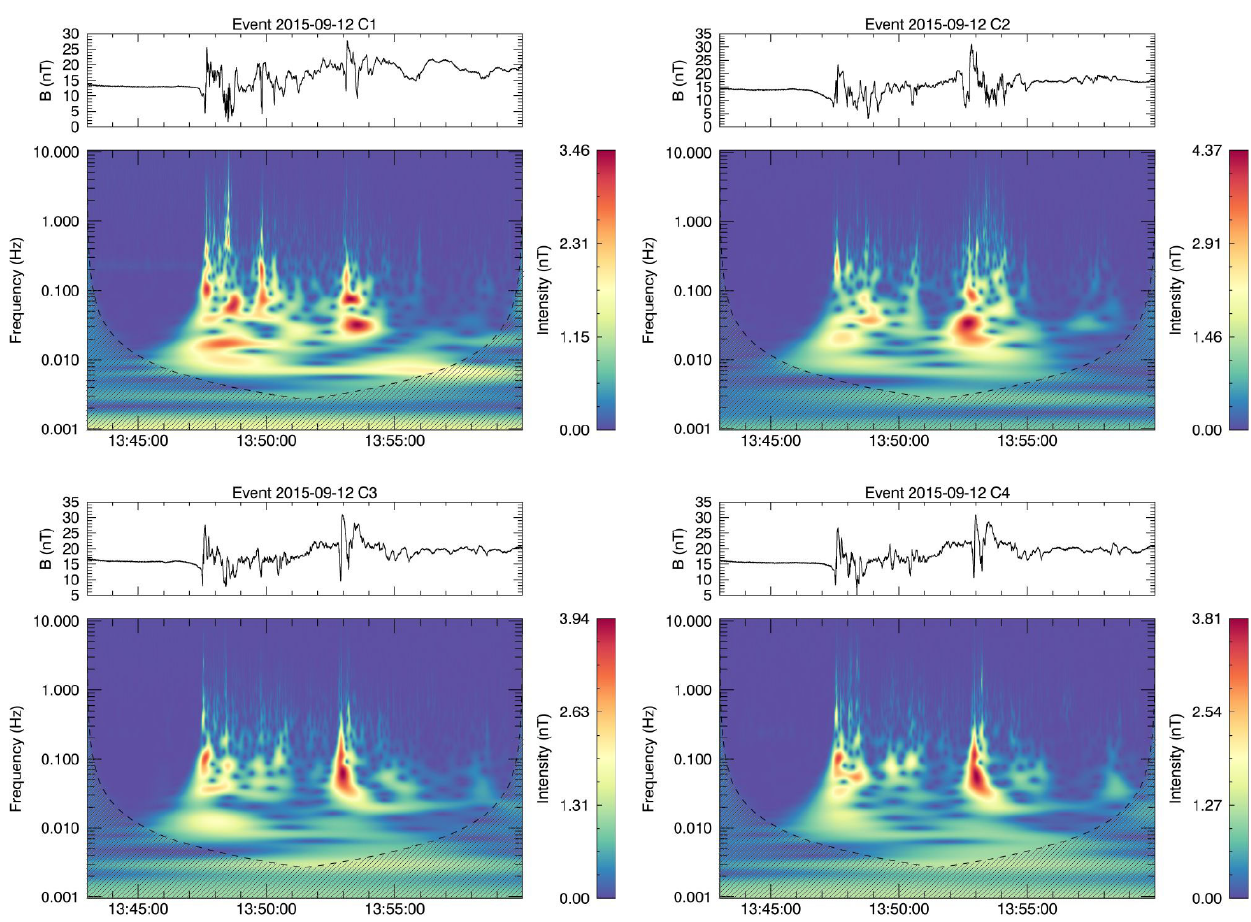
Figure 4. The results of wavelet analysis for event 12 September 2015. The cone of influence is shown by the shaded